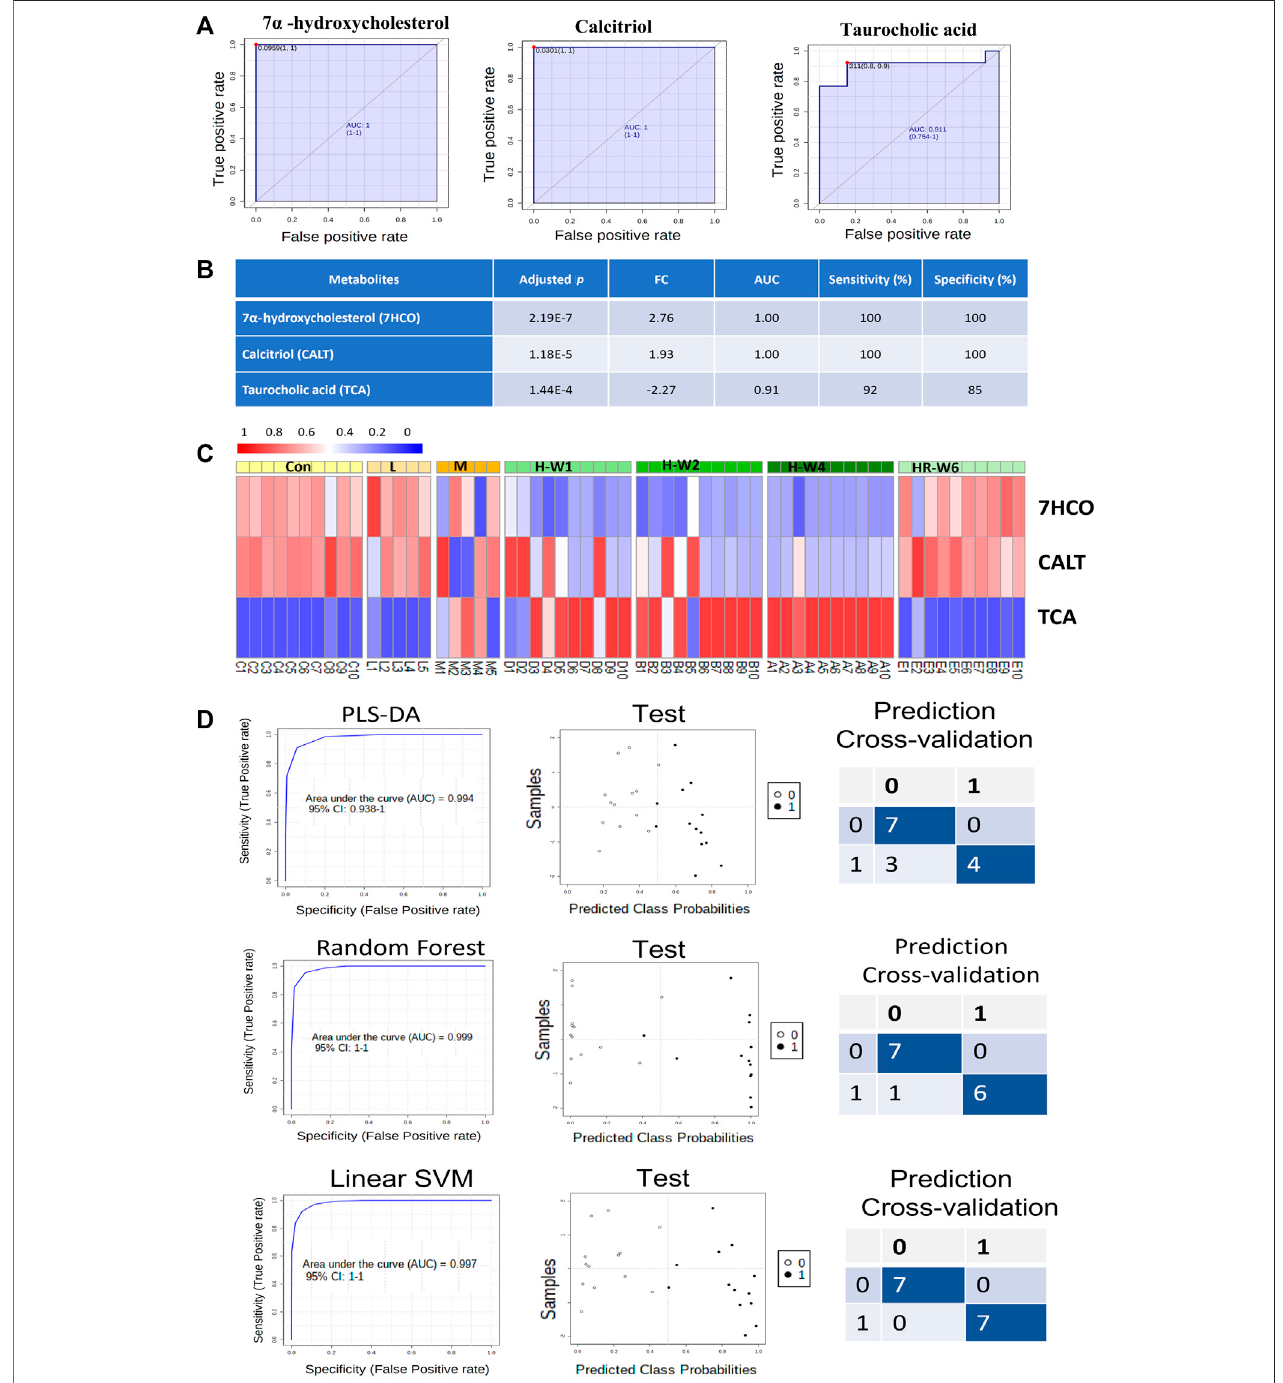
FIGURE 5 | Validation of potential biomarkers of TR-induced toxicity. (A) ROC curves of the three biomarkers. (B) Adjusted p values, FC, AUC, sensitivity, and speci fi city of the three biomarkers. (C) Heatmap of the three biomarkers in the dose – effect and time – course groups after TR administration. (D) Test and prediction results of the models built with the three biomarkers by three machine learning mathematic algorithms: PLS-DA, Random Forest, and Linear SVM.